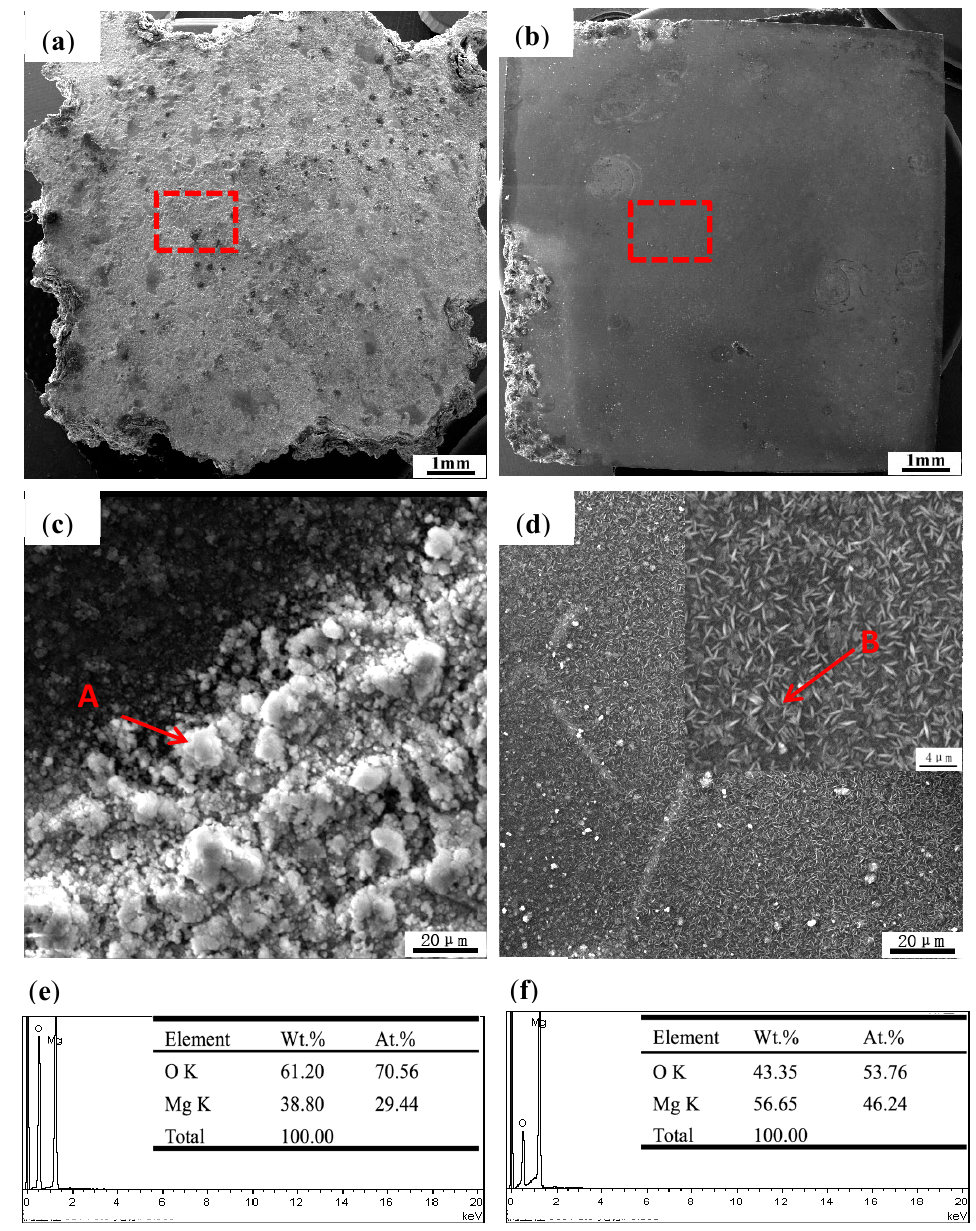
Figure 9. Surface morphologies of macrograph ( a ), micrograph ( c ) (red square in a) of as-extruded; macrograph ( b ), micrograph ( d ) (red square in b) of post-extrusion heat-treated Mg 95.33 Zn 2 Y 2.67 alloys after 98 h immersion; EDS analysis results of point A ( e ) and point B ( f ).